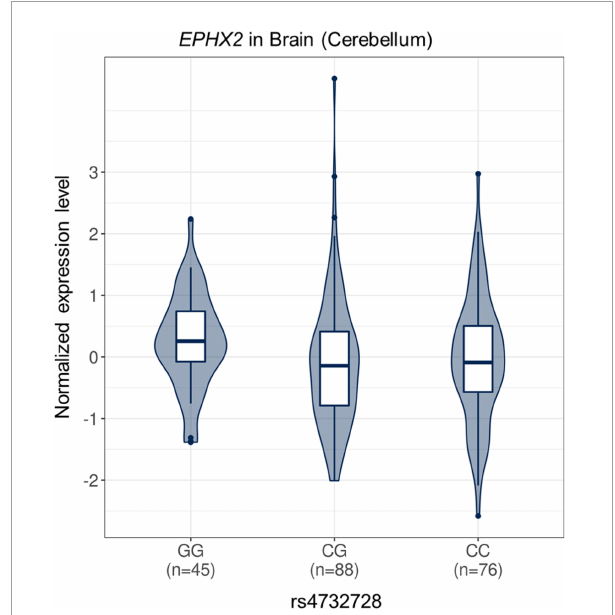
FIGURE3 Violin plot of EPHX2 expression according to rs4732728 genotype. The allelic effect of rs4732728 on normalized EPHX2 gene expression levels are shown. The figure was based on the Genotype-Tissue Expression database (http://gtexportal.org). C, cytosine; G, guanine.